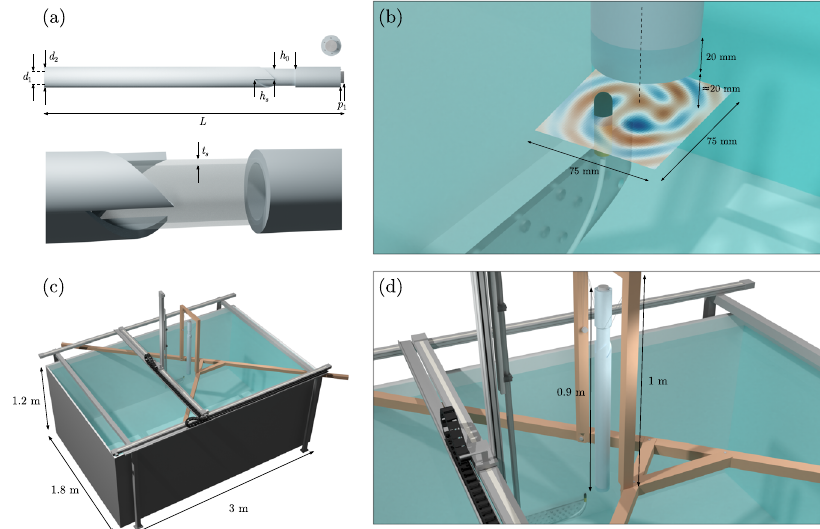
Fig. 1 Experimental Set-up. a Elastic Spiral Phase Pipe: L = 900 mm, d 1 = 40 mm, d 2 = 60 mm, h s = 63 mm, h 0 = 95 mm, p 1 = 12 mm and the thickness at the spiral region, t s = 4 mm (shown in zoom, the spiral region has been made partially transparent). Also shown is a view of the capped end with piezo disk, of diameter 35 mm, and attaching screws. b Acoustic Measurement Centre: Schematic of close-up of the submerged end of the pipe showing orientation of the hydrophone. The measurement plane is approximately 20 mm below the end of the pipe, intersecting the detector at its `acoustic centre'. Shown too is an example experimental pro fi le after frequency domain analysis. c Water tank and xyz scanning stage. d Close-up of suspended pipe and scanning